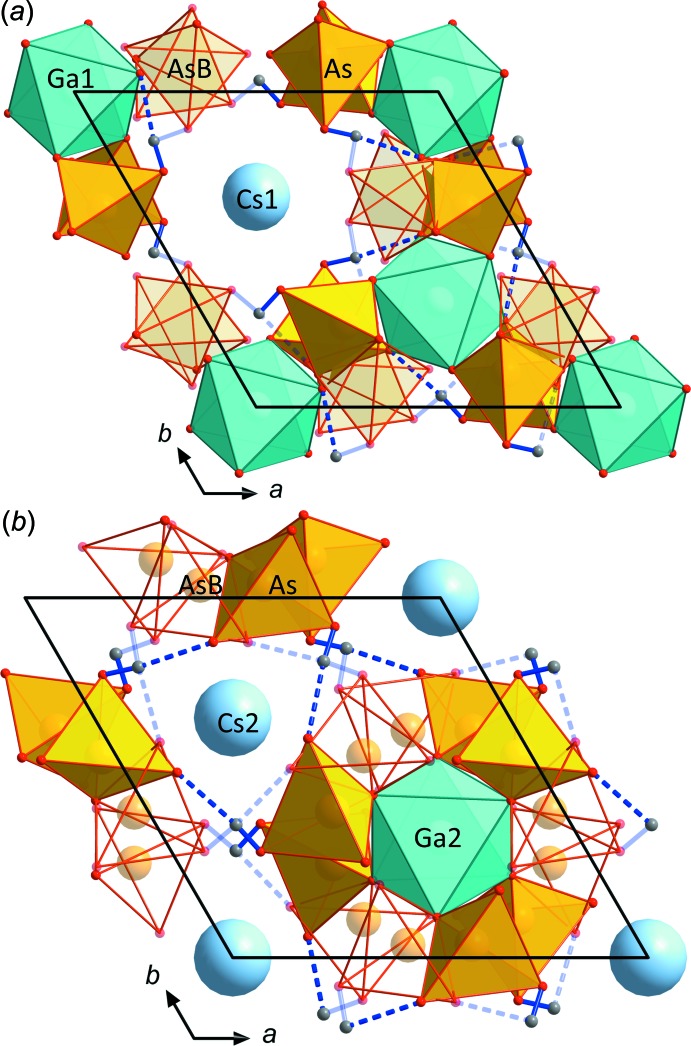
Detailed view of the different layers in the structure of CsGa(HAsO4)2. The alternative AsBO4 tetra­hedra, the alternative hydrogen bonds and OB atoms are shown in transparent mode. (a) The layer showing the Ga1As6O24 group including the alternative AsBO4 tetra­hedra. (b) The layer showing the Ga2As6O24 group including the alternative AsBO4 tetra­hedra and the strongly overbonded Cs2 atom in its void.